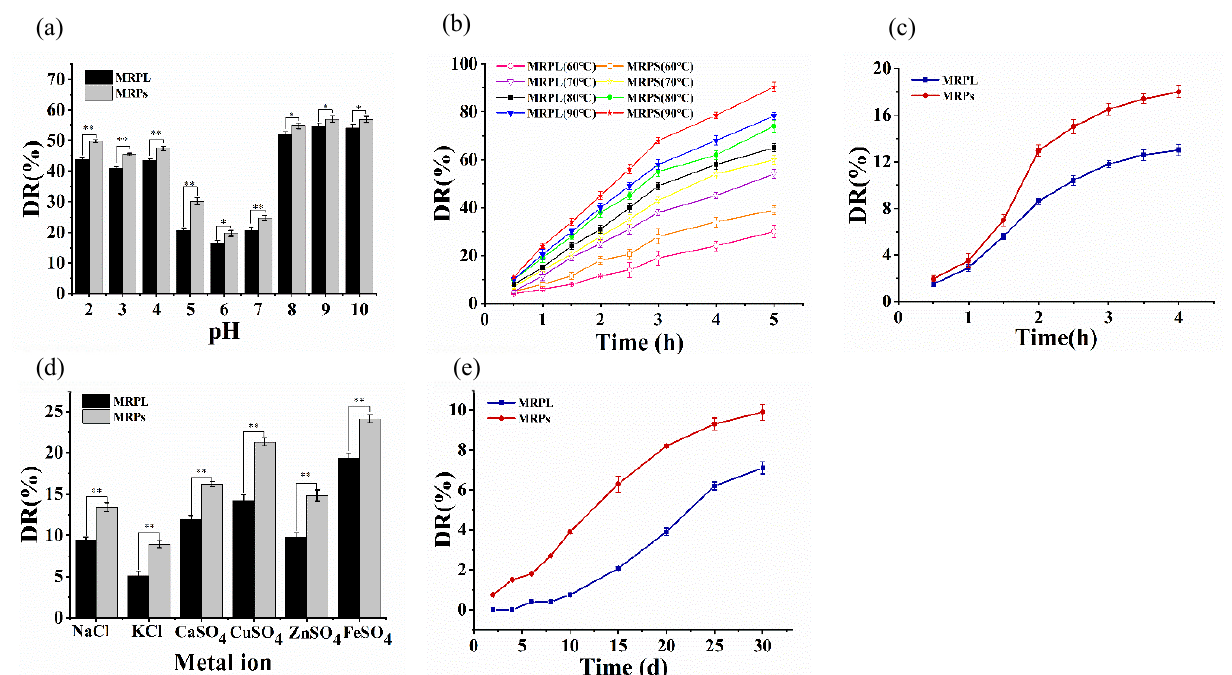
Figure 2. Stability of pH ( a ), temperature ( b ), light ( c ), metal ions ( d ) and storage ( e ) on free MRPs and MRPL. * significant, p < 0.05; ** extremely significant, p < 0.01.